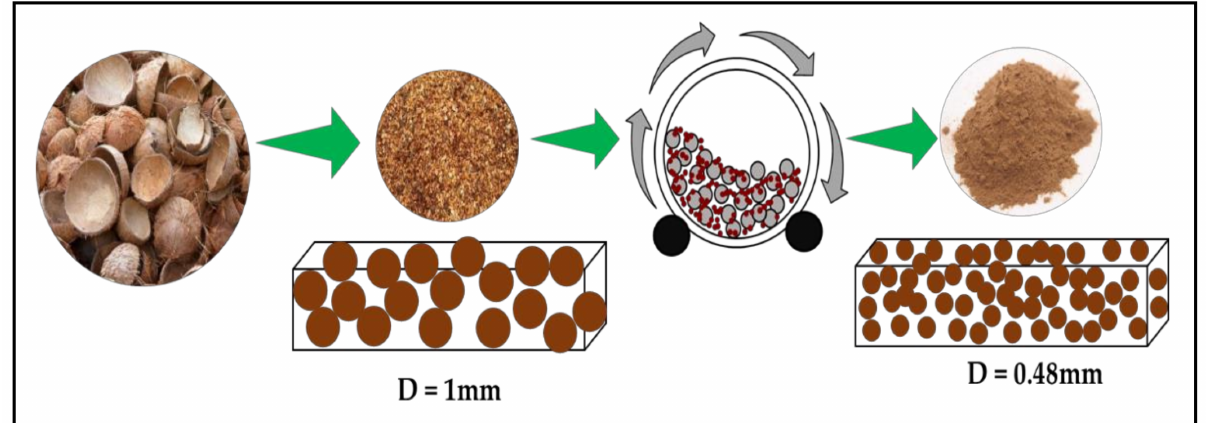
Figure 10. Schematic of reducing the size of filler (particle) from one to nine